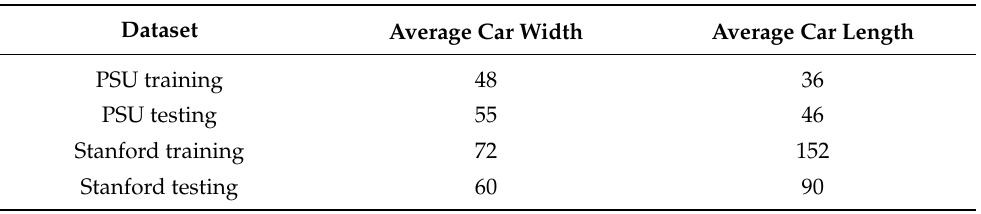
Table 5. Average car width and length (in pixels) in the PSU (Prince Sultan University) and Stanford datasets, calculated based on the ground-truth bounding